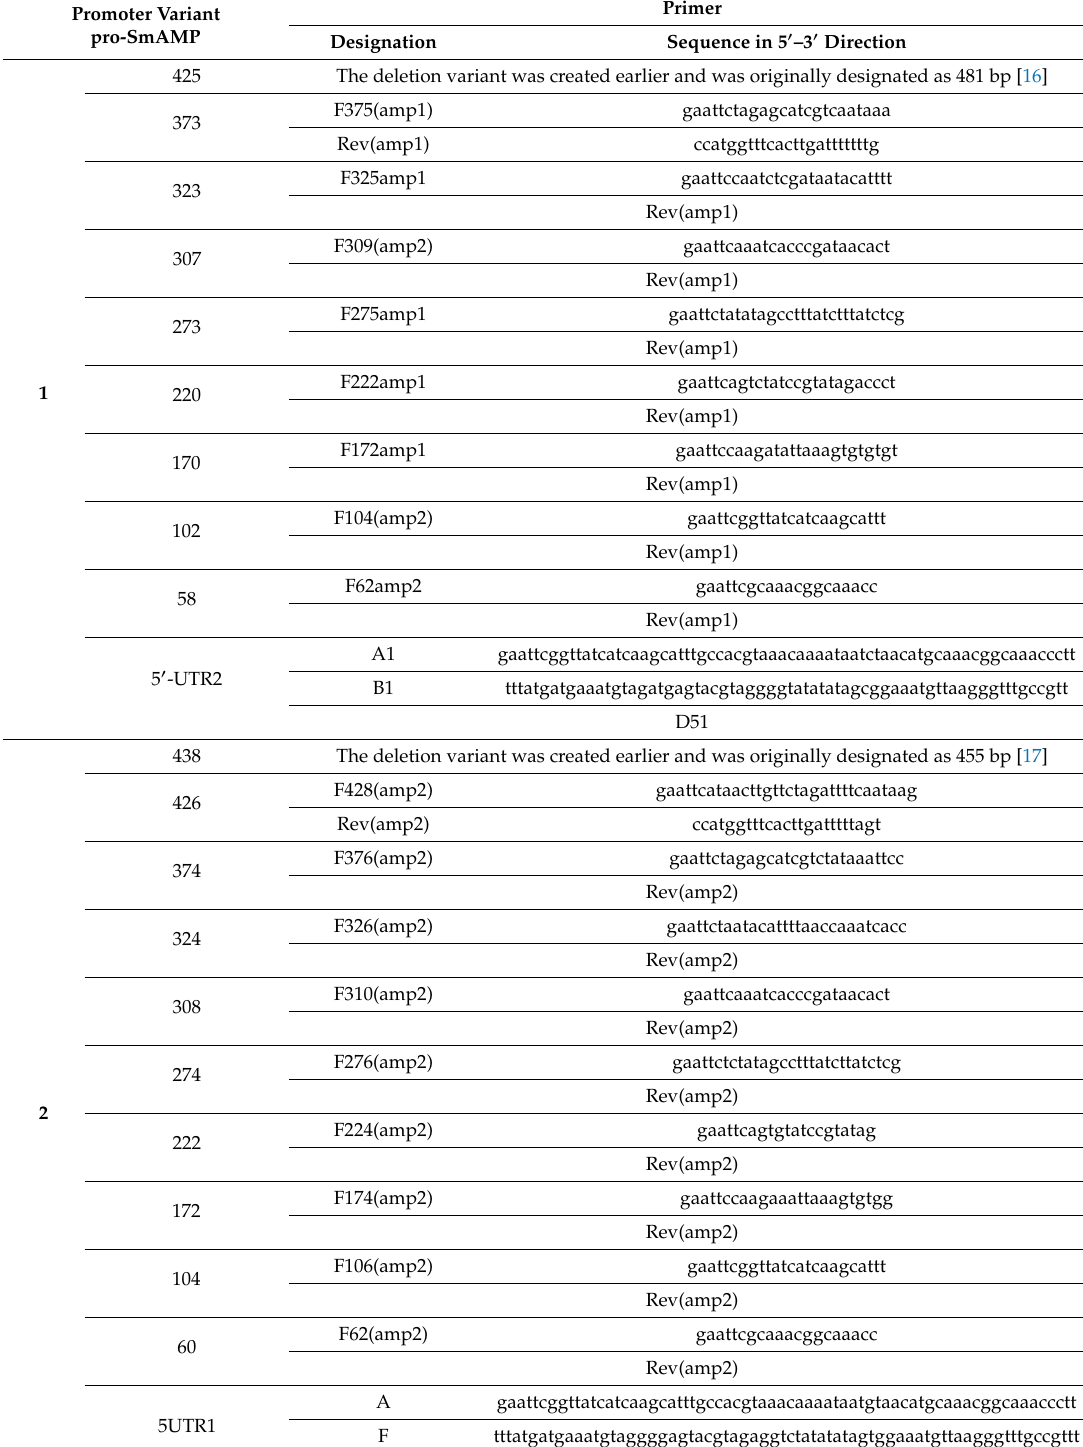
Table A1. Primers for creation of new deletion, chimeric, and synthetic variant